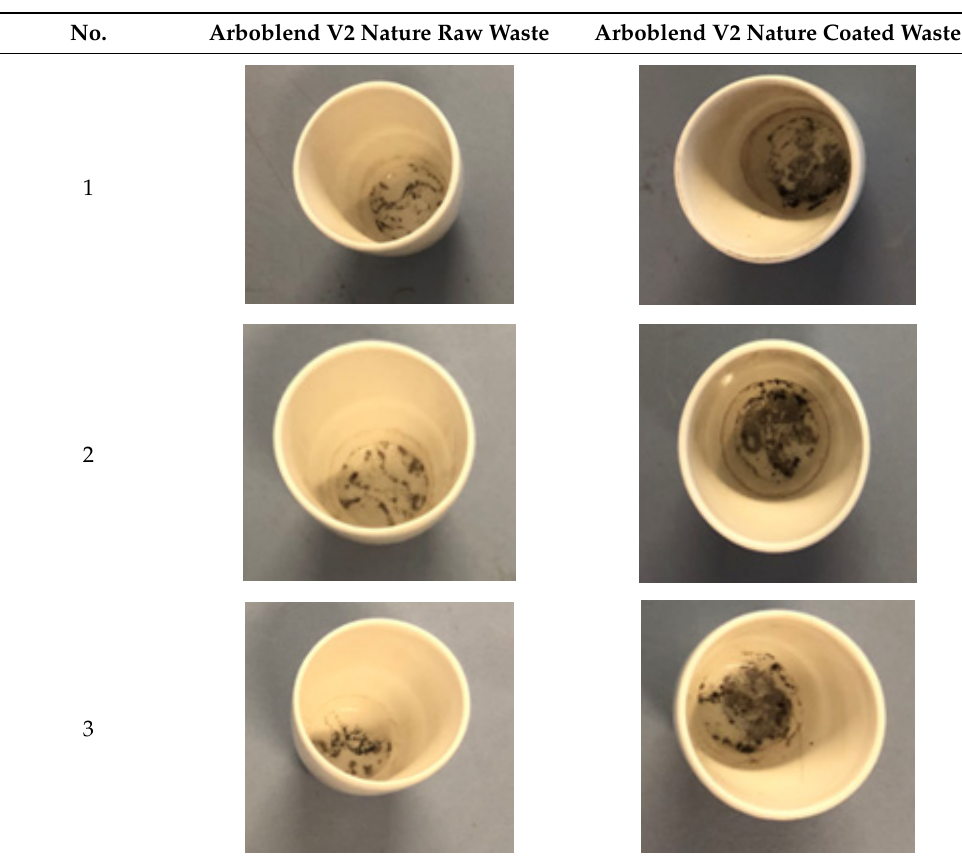
Figure 7. DSC test for silver nano-coated Arboblend V2 sample. Table 3. Representative images for the waste left after the degradation in the furnace of the two samples.